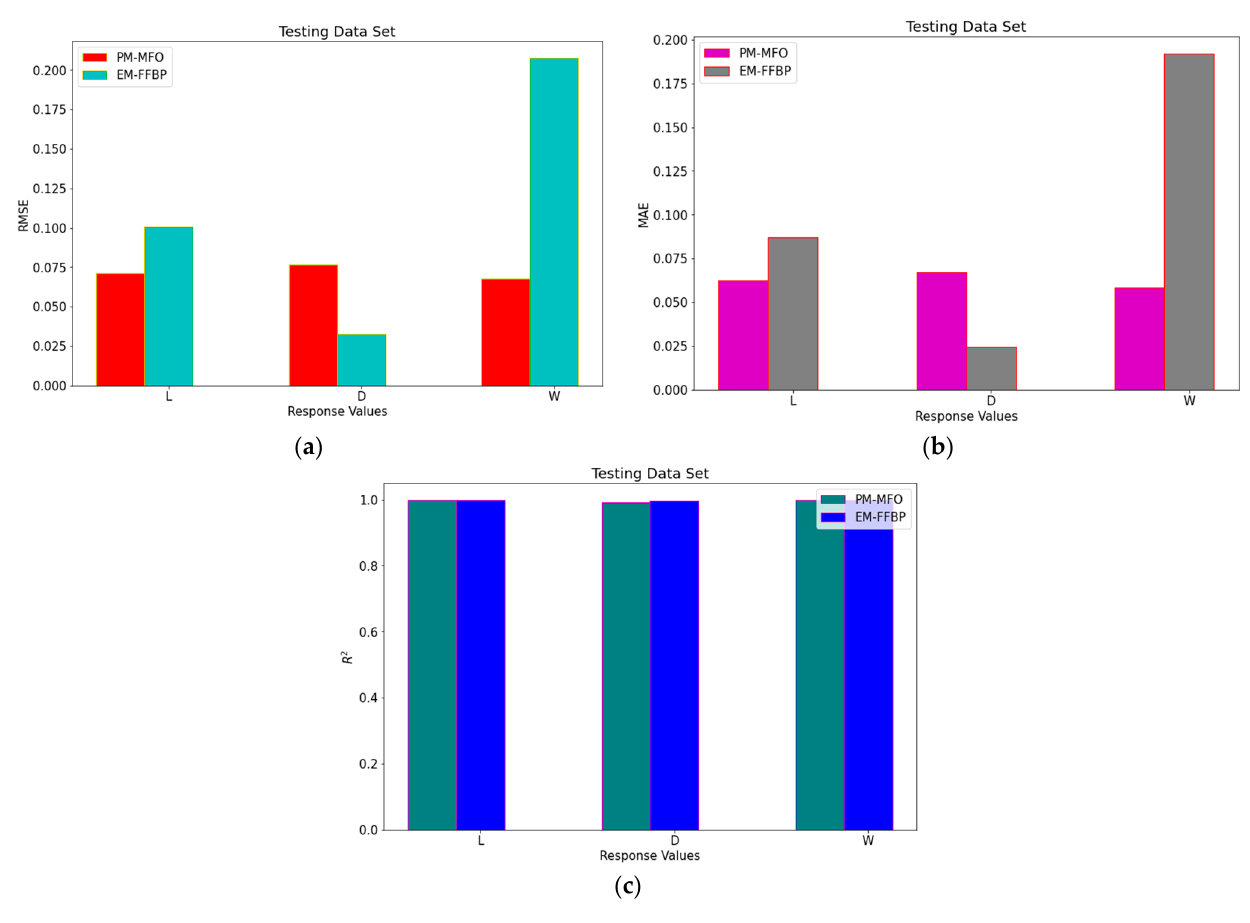
Figure 10. Comparison of performance measures ( a ) RMSE; ( b ) MAE ( c ) R 2 .